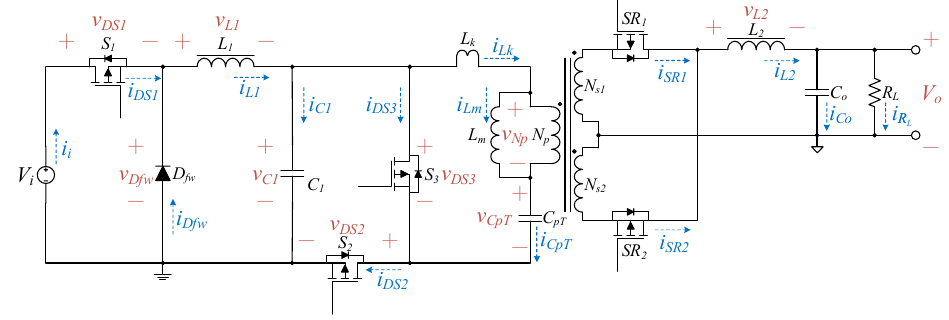
Figure 3. Equivalent circuit of the proposed IBAHB.